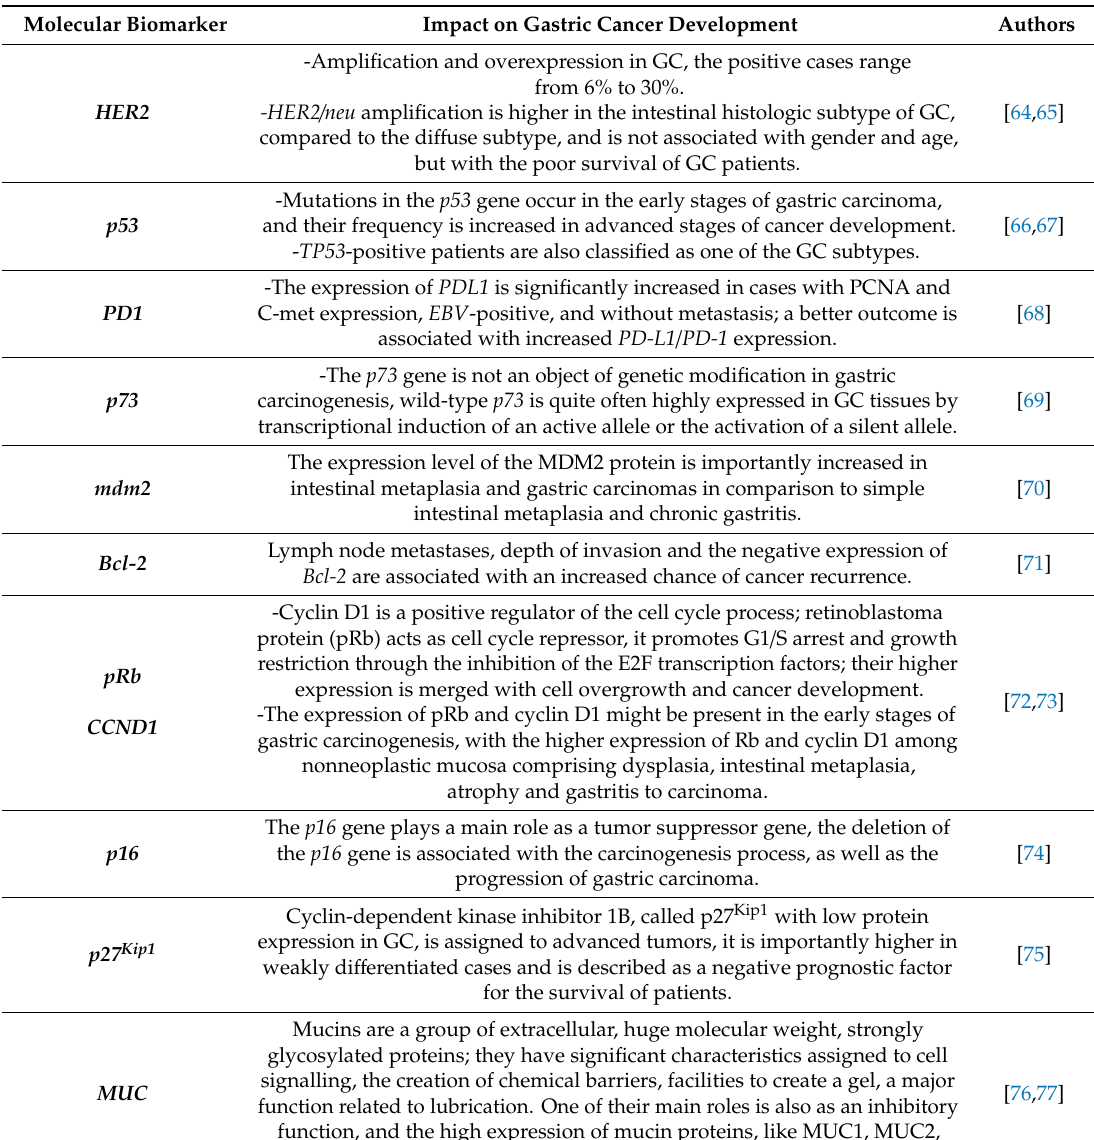
Table 1. Molecular biomarkers in gastric cancer